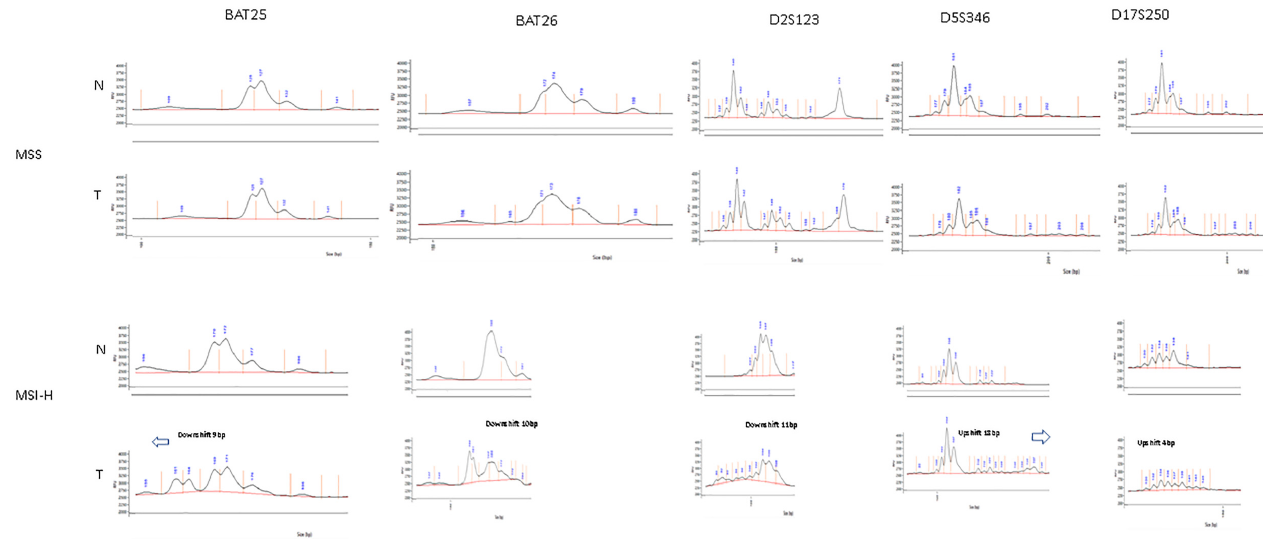
Figure 3. Example of visual inspection of electropherogram for tumour specimens—above (MSS) showing identical electropherograms between tumour and matched normal tissue, below (MSI-H) showing allelic shift between tumour and matched normal tissue on electropherogram.